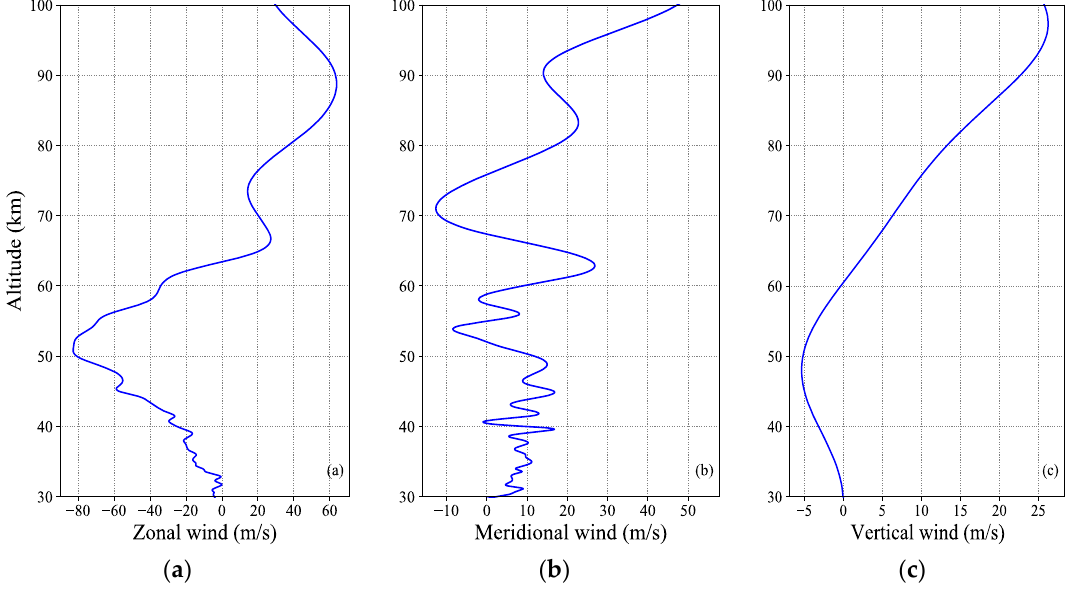
Figure 4. The simulated three-dimensional wind field. ( a ) Zonal wind; ( b ) meridional wind; ( c ) vertical wind.